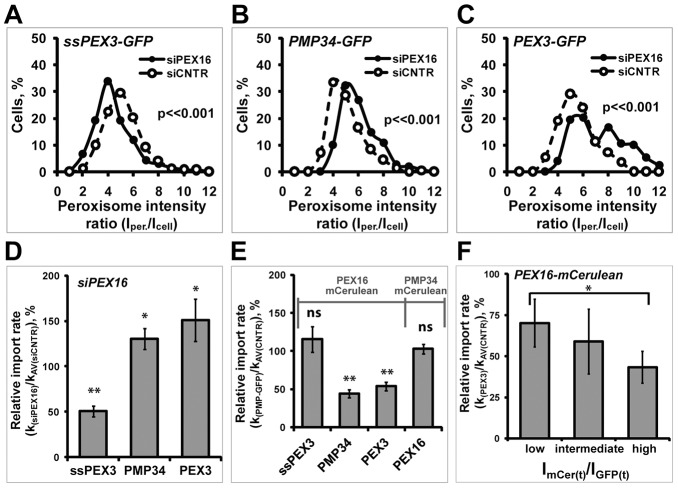
Depletion of PEX16 expression delays ssPEX3-GFP import into peroxisome, whereas overexpression of PEX16 decreases the peroxisome import of PEX3-GFP and PMP34-GFP. (A–C) The distribution of PMP-GFP signal within peroxisomes (Iper.) with respect to the average fluorescence signal, within the whole cell (Icell) treated with either siPEX16 or siCNTR, are shown in a histogram as a ratio (Iper./Icell) for (A) ssPEX3-GFP, (B) PMP34-GFP, and (C) PEX3-GFP. The distributions for each PMP in siPEX16-treated cells were significantly different from that in control cells (siCNTR) (P<<0.001, n = 50). A scatter plot of the same data (A–C) is shown in supplementary material Fig. S3 (C–E). (D) The peroxisomal import rates [k(siPEX16)] of ssPEX3-GFP, PMP34-GFP, and PEX3-GFP in PEX16-depleted cells compared to siCNTR-treated [kAVsiCNTR)] cells are shown in a bar graph. (E) The peroxisomal import rates [k(PMP-GFP)] of ssPEX3-GFP, PMP34-GFP, PEX3-GFP or PEX16-GFP in cells co-expressing PEX16-mCerulean or PMP34-mCerulean, as indicated, compared to the average rates of the corresponding PMP-GFP construct in cells co-expressing mCerulean [kAV(CNTR)] are shown in a bar graph. (F) The rate of PEX3-GFP import into peroxisomes decreased with increasing PEX16-mCerulean expression. Shown here is a different representation of the data presented in E. Here, the relative import rate of PEX3-GFP compared to control is plotted based on its ratio of PEX16-mCerulean over the total PEX3-GFP fluorescence signal [ImCer(t)/IGFP(t)]. The rates are subdivided into three groups (with a comparable number of cells in each group) from low to high ImCer(t) to IGFP(t) ratio. The error bars indicate ±s.e.m. *P<0.05; **P<0.005; ns, not significant.